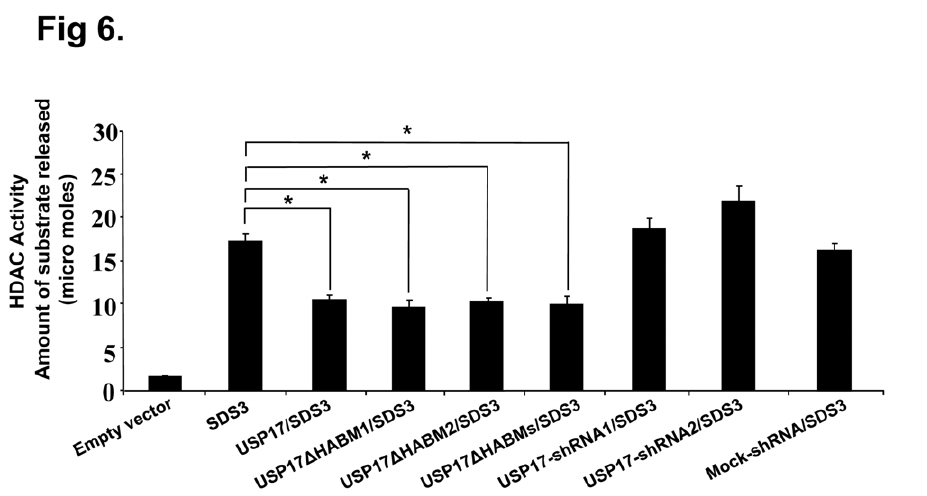
Figure 6. HABMs deleted USP17 does not alter SDS3-associated HDAC activity. HeLa cells were transfected with empty vector, SDS3, USP17/SDS3, USP17 D HABM1/SDS3, USP17 D HABM2/SDS3, USP17 D HABMs/SDS3, USP17-shRNA1/SDS3, USP17-shRNA2/SDS3, and Mock-shRNA/SDS3. HDAC activity on anti-SDS3 immunoprecipitates was determined by measuring released deacetylase substrate using HDAC assay kit. A mean of triplicate measurements; bars, Standard deviation, n=3. *, p , 0.05.